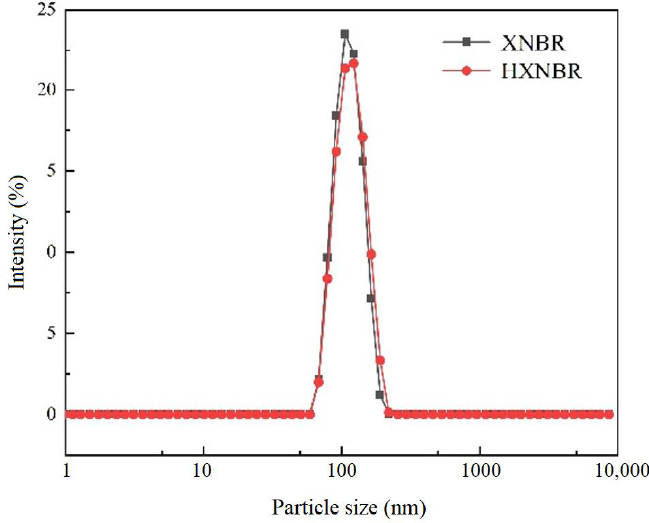
Figure 2. The size distribution of XNBR particles in latex before and after hydrogenation.